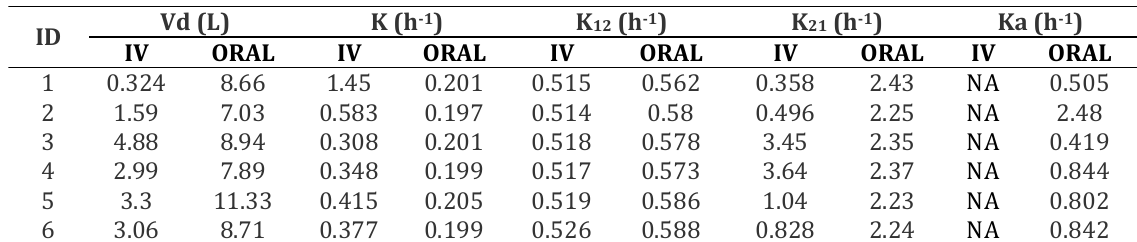
Figure 5. The goodness of fit of a two-compartment open model after a simultaneous fitting of intravenous bolus injection and peroral administration of levofloxacin, i.e., individual data fitting analyses (panel A); observation versus population prediction analysis (panel B) and observation versus individual prediction analysis (panel C), with a combination error model implemented. Table I. The estimated individual values of levofloxacin pharmacokinetic parameters following intravenous bolus injection and peroral administrations.